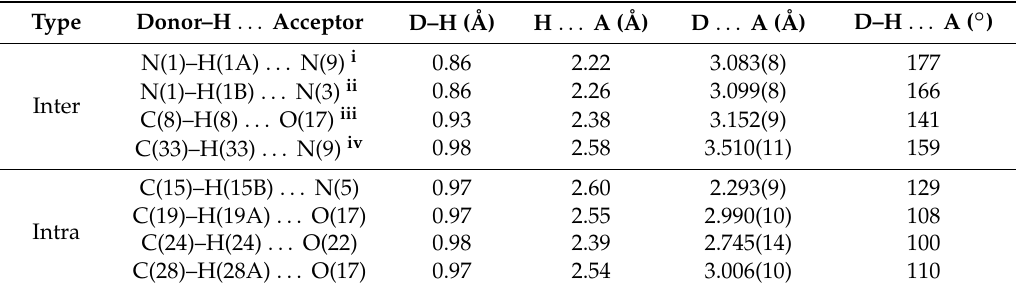
Table 3. Inter- and intra-molecular hydrogen bonds in Tenofovir disoproxil (TD) free base.